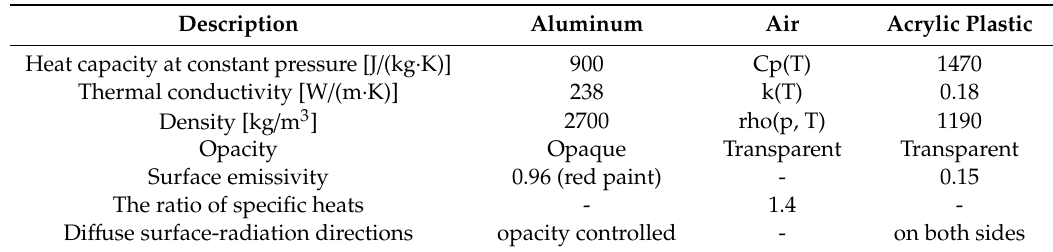
Table 1. Material parameters applied in the